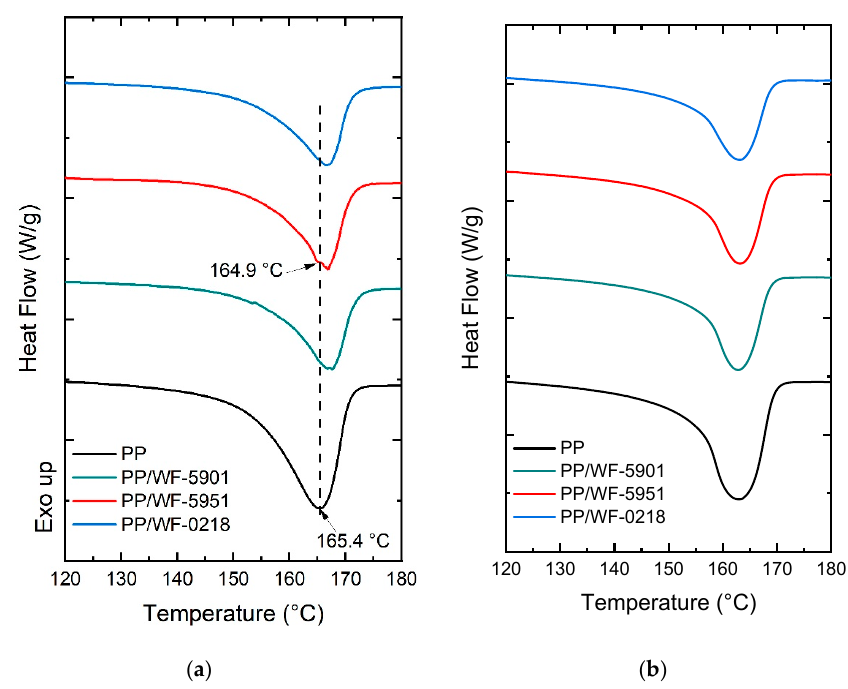
Figure 4. DSC heating scan for ( a ) the first heating and ( b ) the second heating scans.